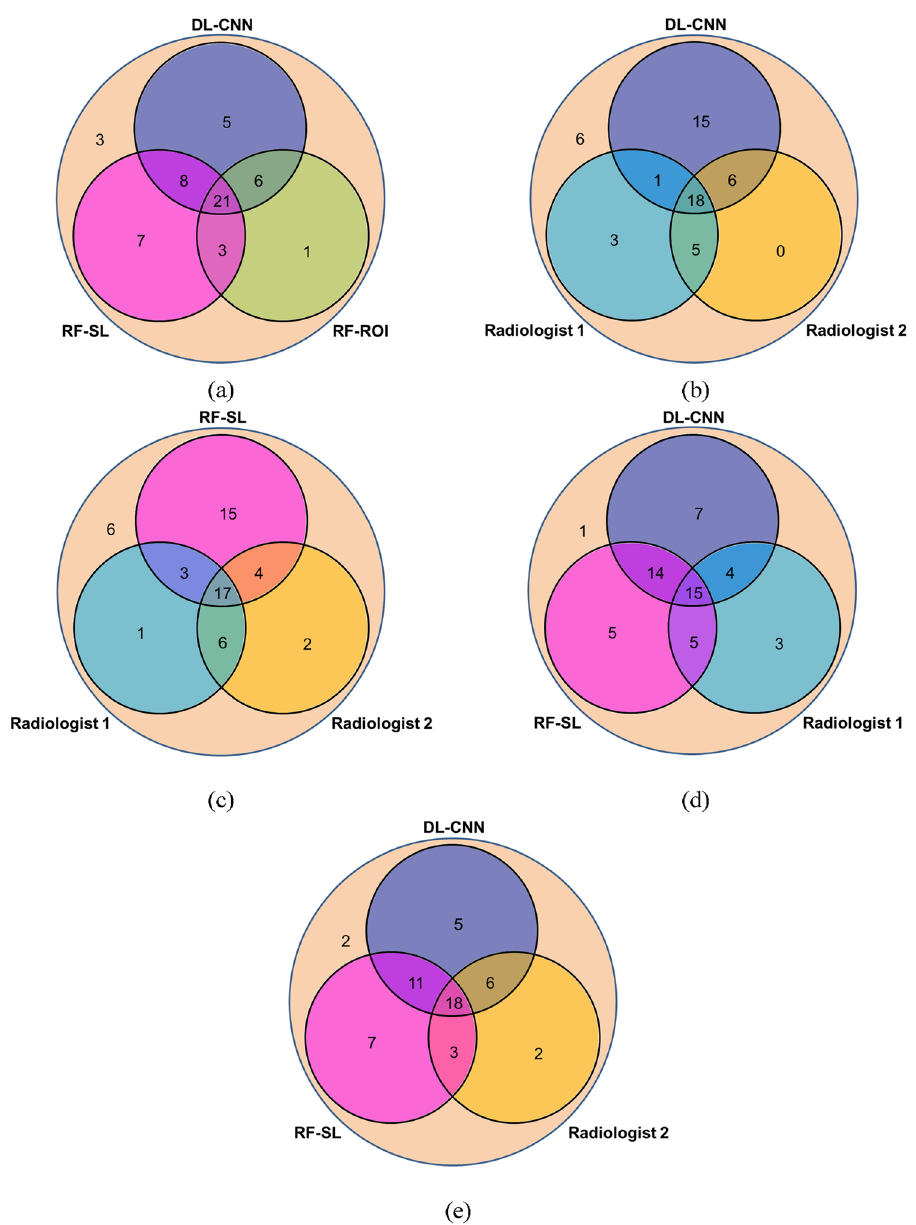
Figure 8. Venn diagrams of different methods and their assessments for the test set. The inner three circles compare the methods when at least one method correctly predicted the treatment outcome for a pre- and post-treatment pair. The outer circle contains the pre- and post-treatment pairs for which all three methods incorrectly predicted the treatment outcome. ( a ) The three computer methods correctly predicted the same outcome of the patients for 39% (21/54) of the pre- and post-treatment pairs. ( b , c ) The two radiologists correctly agreed on the outcome of 43% of the cases ((18 + 5)/54 for ( b ) and (17 + 6)/54 for ( c )). ( d , e ) Radiologists 1 correctly agreed with the DL-CNN and the RF-SL methods for 19 and 20 cases, respectively, while Radiologist 2 correctly agreed with the DL-CNN and the RF-SL methods for 24 and 21 cases,